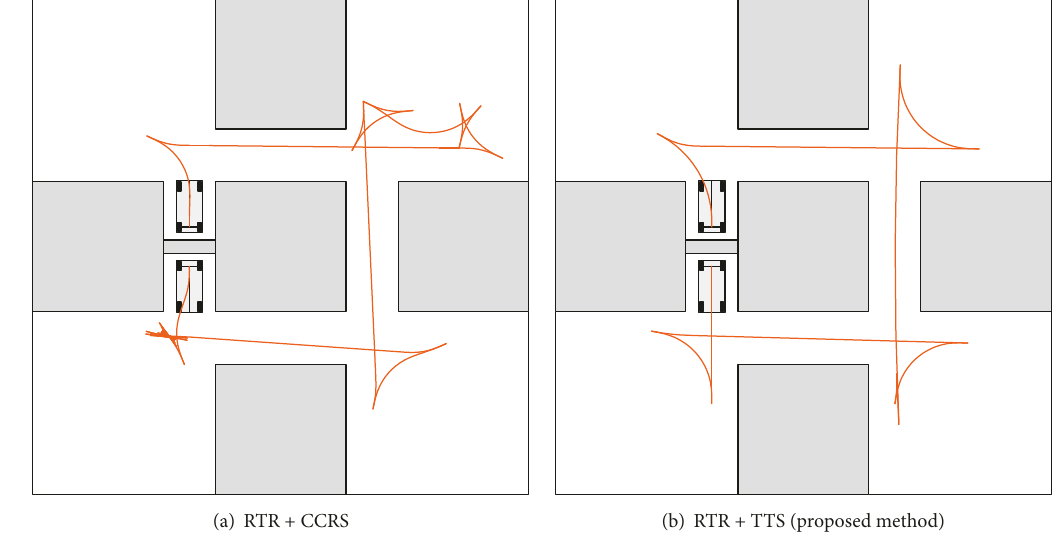
Figure 15: Crossing three narrow corridors.